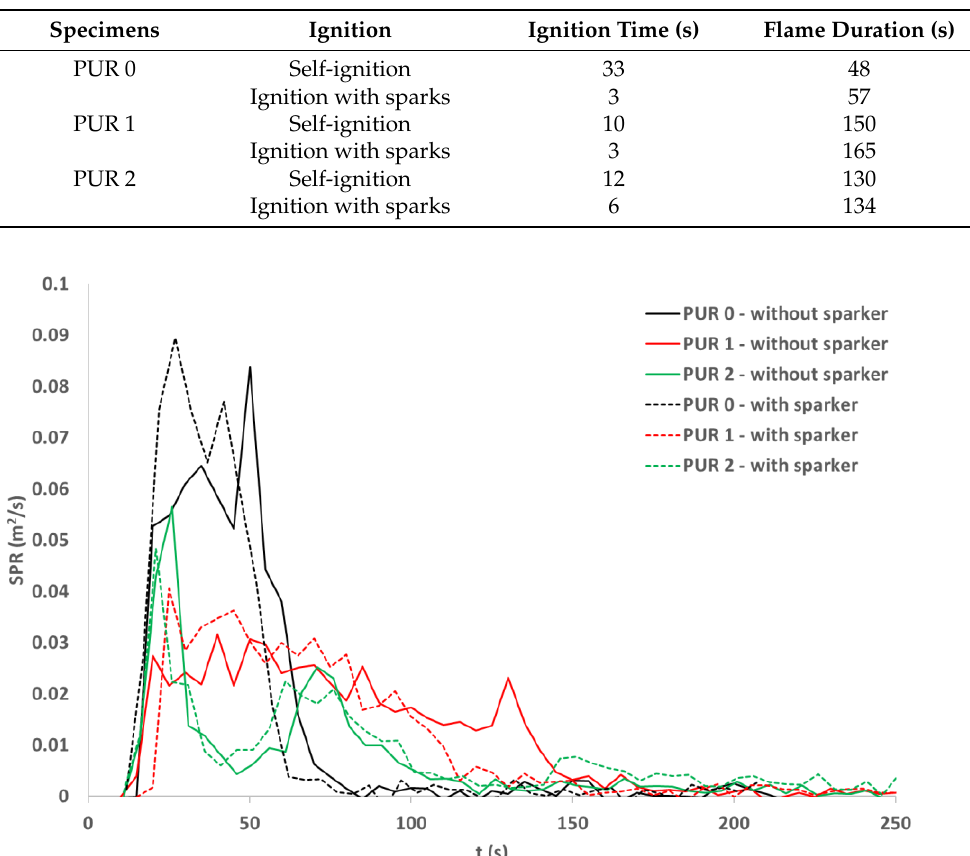
Figure 6. Total heat release (THR) of the PURs exposed to the 40 kW/m 2 of heat flux; self-ignition and spark ignition. Table 6. Ignition times and flame duration for the three PURs exposed to 40 kW/m 2 of heat flux self-ignited or ignited with a spark igniter.